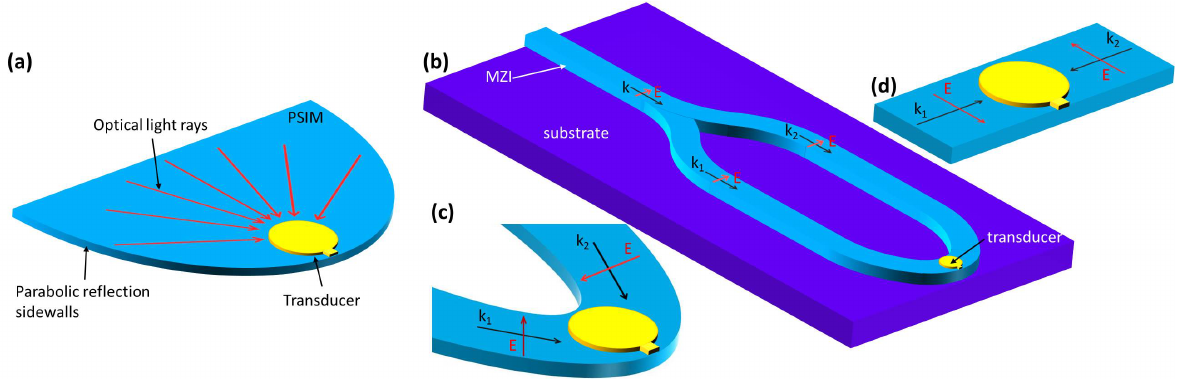
Figure 1: (a) A planar solid immersion mirror (PSIM) and near-field transducer (NFT) placed at the focus of waveguide with beams coupled to the NFT with different angles. (b) Mach–Zehnder interferometer planar waveguide coupling arrangement for coupling light to the NFT located at the output Y junction with light coupled to a transducer with flexible angle (c,